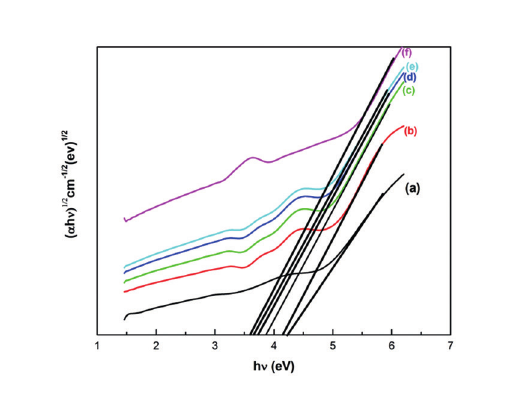
Figure 8: (αhν) 1/2 vs hν plots of pure and Mn 2+ doped PVC polymer films (a) Pure (b) 1mol % (c) 2 mol % (d) 3 mol % (e) 4 mol% (f) 5